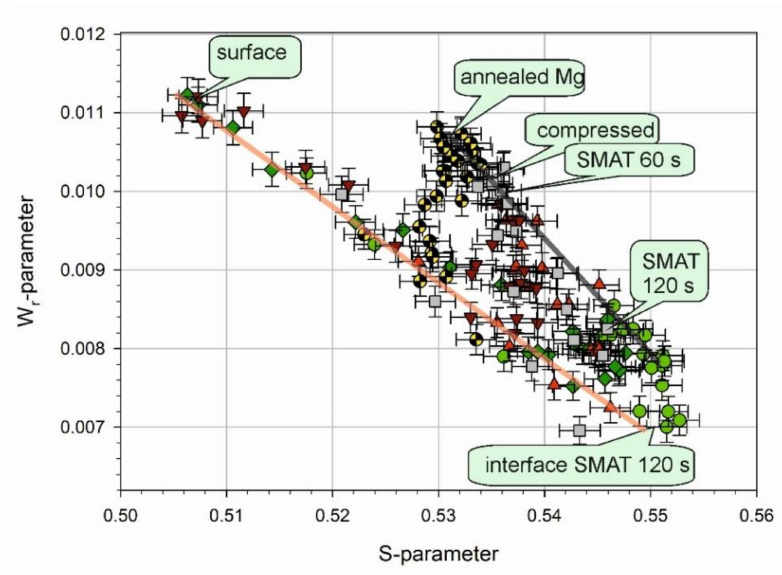
Figure 6. W r -parameter as a function of S -parameter. The symbols are the same as in Figure 5.